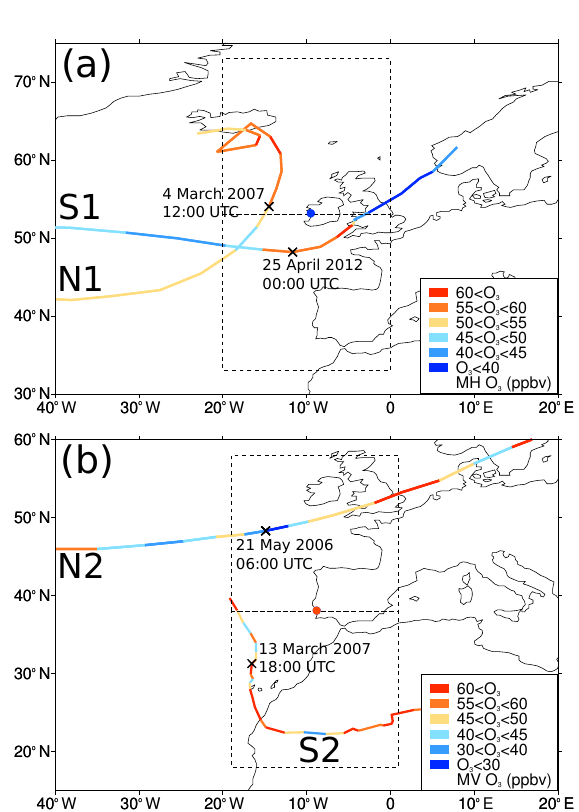
Figure 2. (a) Springtime strong cyclone tracks, N1 and S1, associ- ated with high O 3 (O 3 > 75th pc) at Mace Head (blue dot) while in the North and South regions, respectively. Tracks colored by MACC O 3 interpolated to the Mace Head location. (b) Springtime strong cyclone track, N2, in the North region and moderate cyclone track, S2, in the South region which are associated with high O 3 at Monte Velho (orange dot). Tracks colored by MACC O 3 interpo- lated to the Monte Velho location. The time of maximum vorticity of each track is given at the location along the track, indicated by the